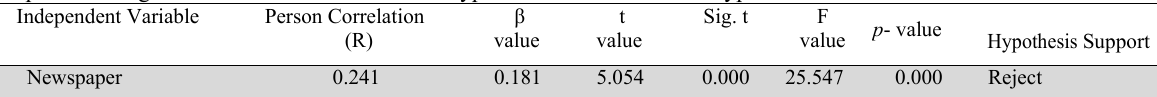
Simple linear regression results for the third sub hypothesis of the main first hypothesis Independent Variable Person Correlation (R) Newspaper